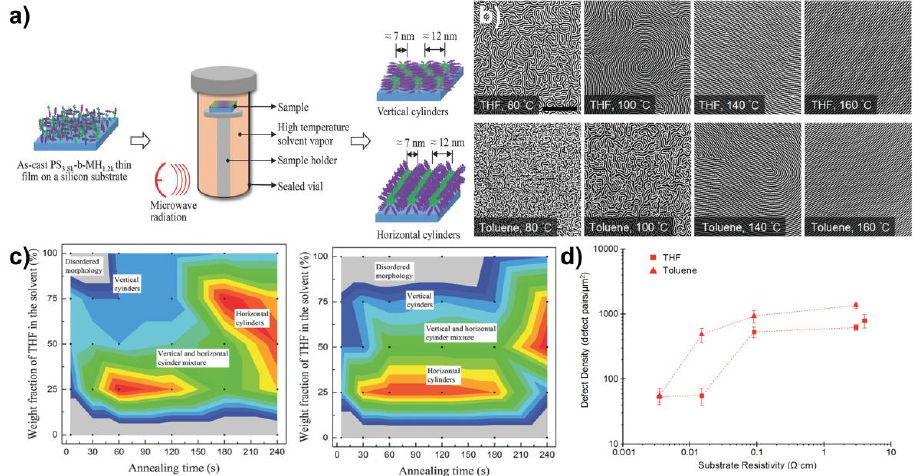
Figure 5. ( a ) Schematic representation of the microwave assisted solvent annealing and reorganization of the BCP morphologies [84] . ( b ) The effect of the annealing solvent on the formation of the well-ordered morphologies in the PS-b-PMMA films during the microwave-assisted solvent annealing [77]. ( c ) Evolution of the morphology with time, under different temperatures (left: 130 °C, right 160 °C), during the microwave-assisted solvent annealing (gray: disordered; blue: vertical cylinders with vertical orientation; green: orientation transition area; red: horizontal cylinders) [84] . ( d ) Plots of the evolution of the defect density vs. the substrate resistivity. Dotted lines not intended to convey any interpolated information [77] . Adapted with permission from references [77,84] .